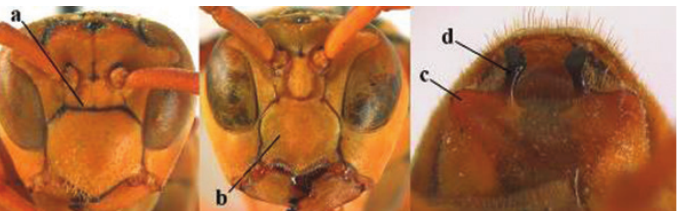
Female: Dorsal part of epistomal (frontoclypeal) suture blackish or dark brown (a); length of fore wing 15–28 mm. Male: Clypeus evenly convex (b); lateral tubercles on each side of apex of last sternite subtriangular and wider basally (c), its terminal apophyses long and spatulate apically (d); Palaearctic distribution: Egypt, Oman, Iran, Afghanistan .. P. olivaceus (DeGeer, 1773)